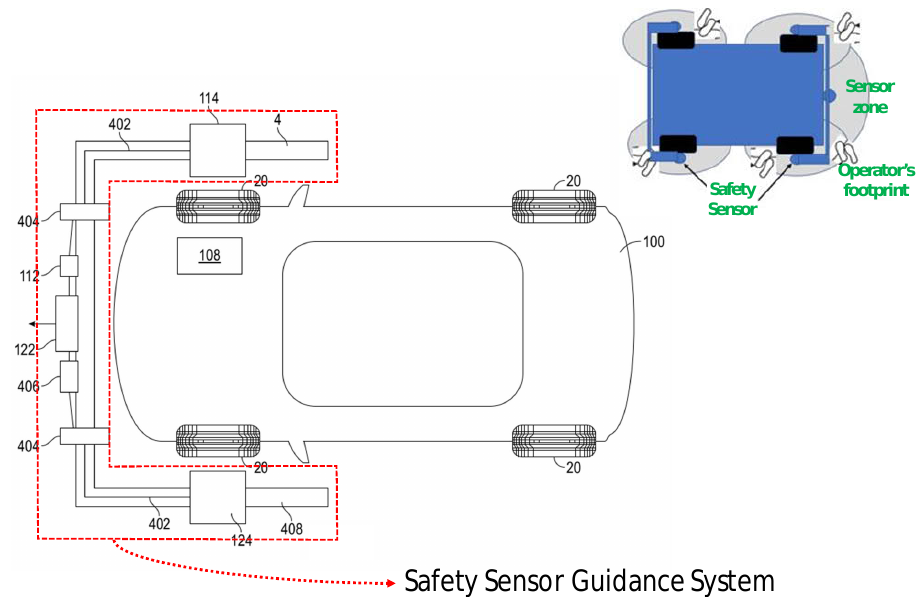
Figure 4. VaaC equipped with a safety sensor guidance system.